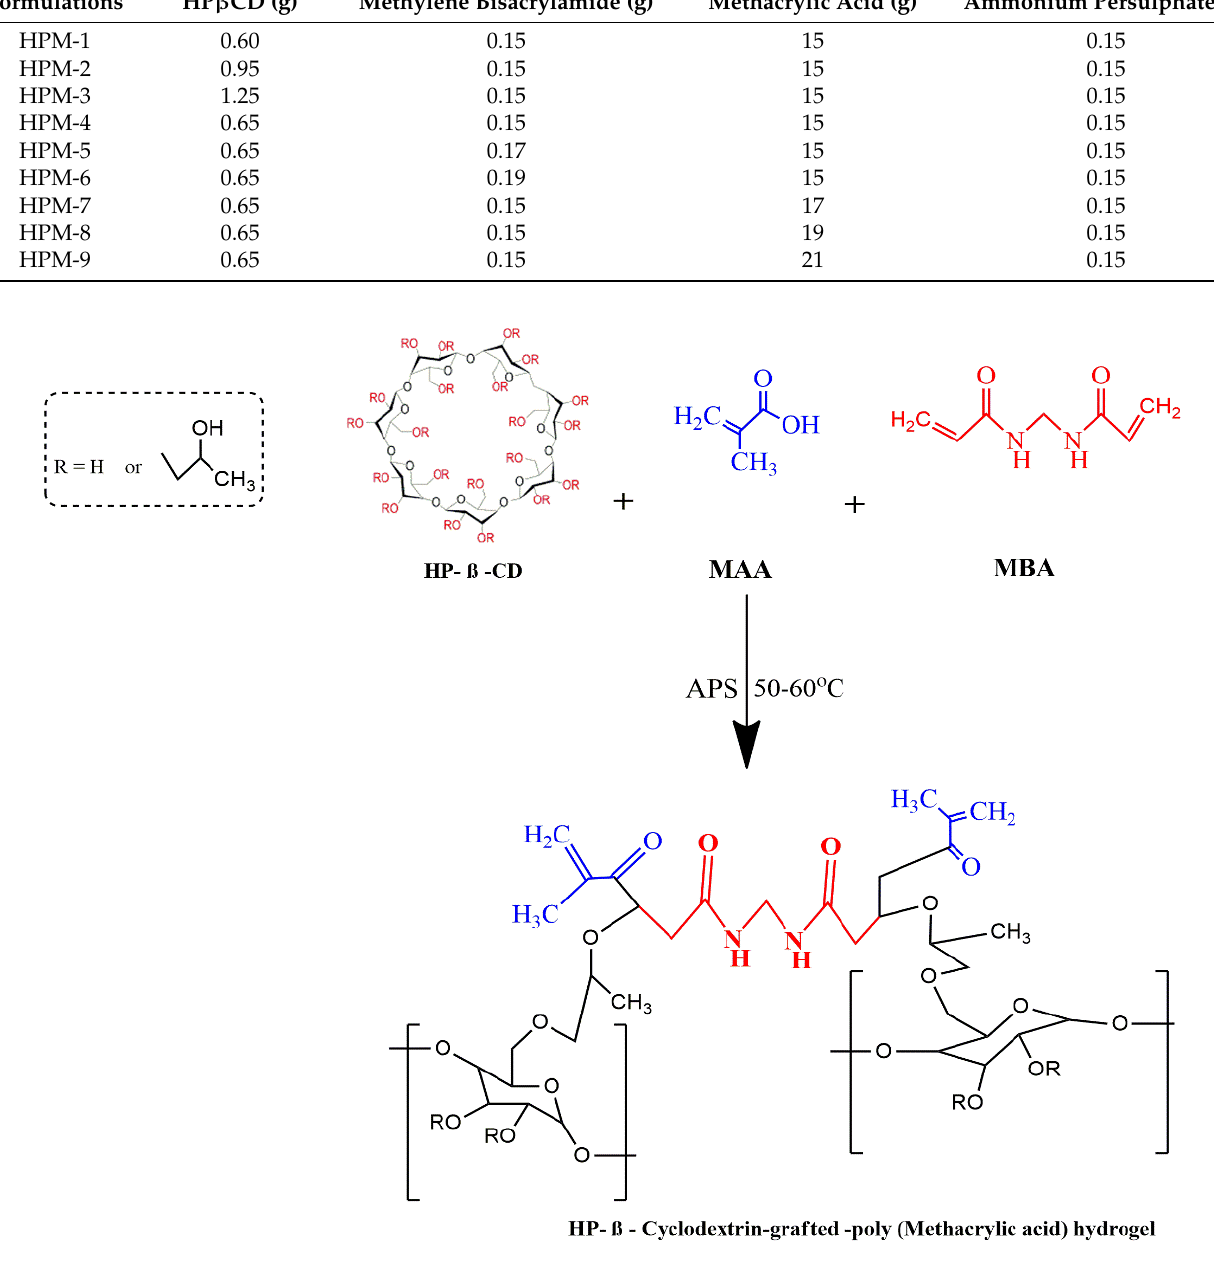
Figure 14. Schematic presentation of developed HP β CD-grafted-poly (MAA) hydrogels. Table 6. Composition of HP β CD-grafted-poly (MAA) hydrogels (HPM-1 to HPM-9).